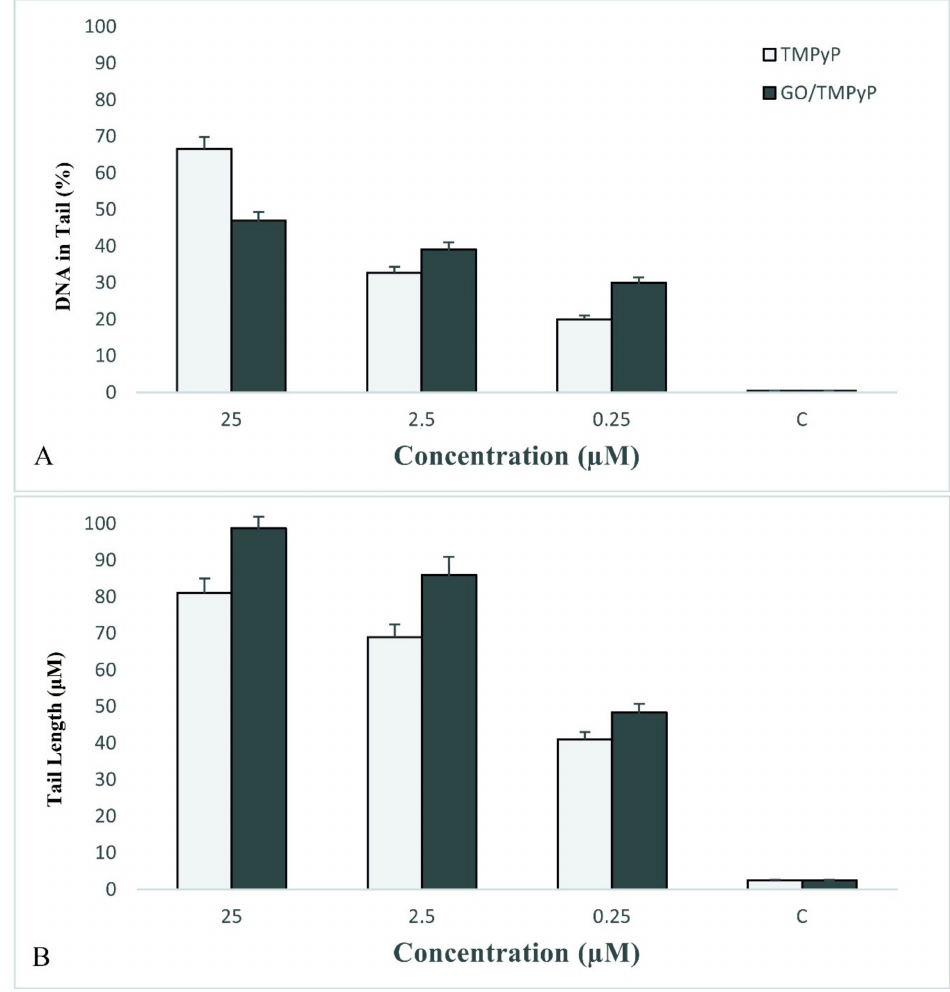
Figure 8. Percentage of DNA in tail ( A ) and tail length ( B ) determined by comet assay in concentrations of 25 µ M, 2.5 µ M, and 0.25 µ M of TMPyP and GO / TMPyP nanocarrier on the HeLa cell lines. Data represent mean and standard error from three independent